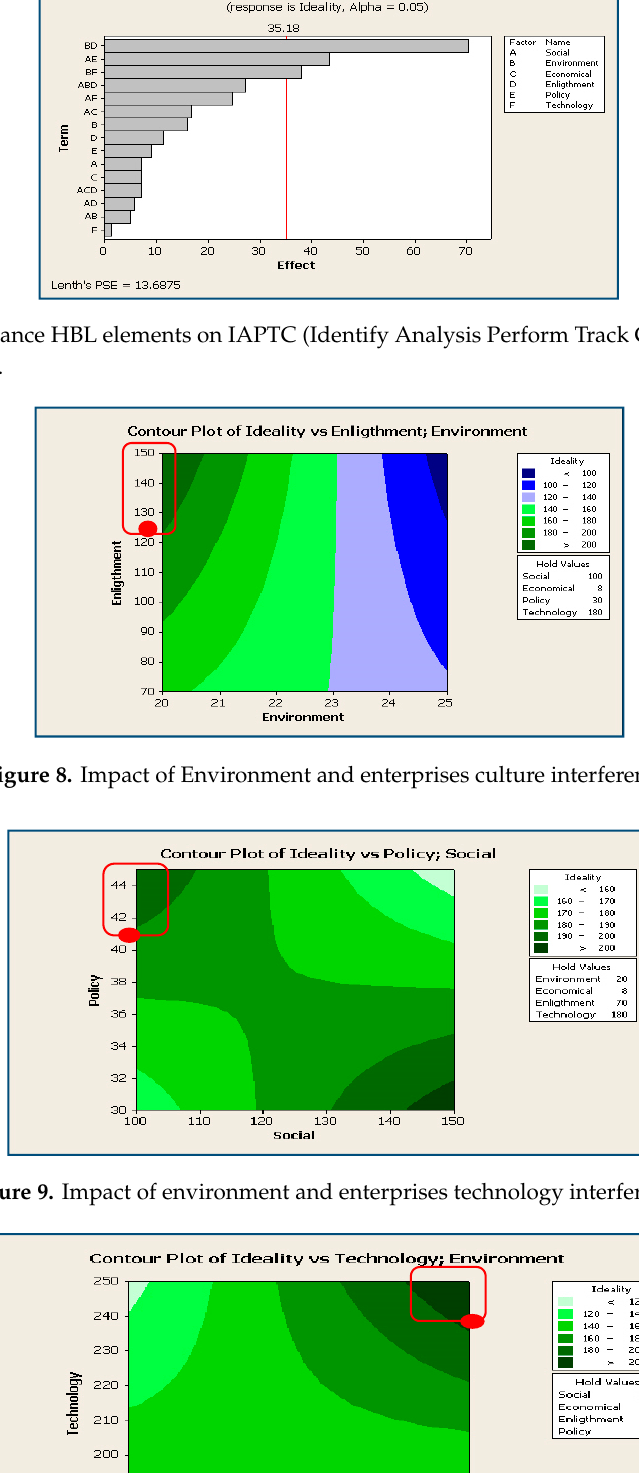
Table 16. Results of fit indices for CFA.